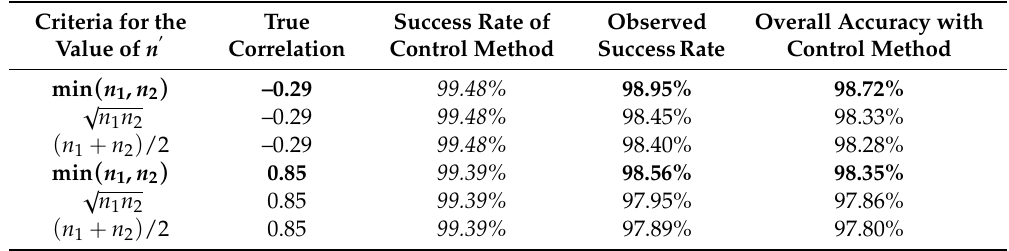
Table 2. Comparison of the success rates of the estimated 95% confidence interval for the correlation coe ffi cient and overall accuracy with the control method for the three di ff erent criteria of e ff ective sample size n (cid:48)